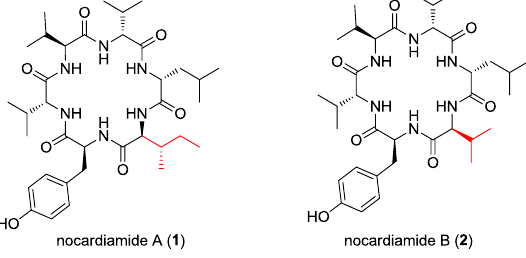
Figure 2. Structures of naturally occurring nocardiamides A ( 1 ) and B ( 2 ).